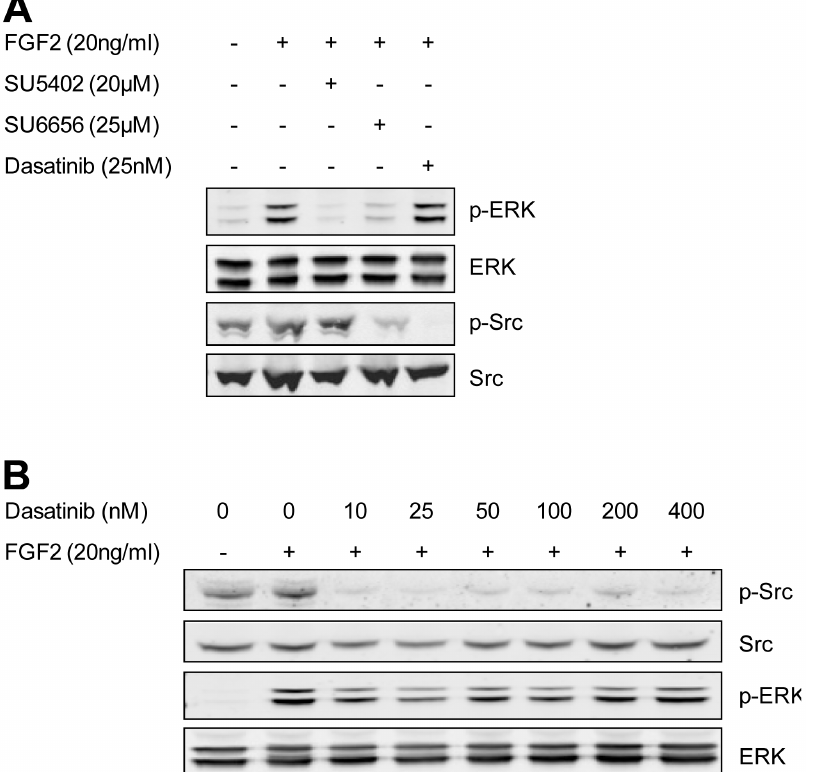
Figure 1. Chemical inhibition of Src kinase and FGFR kinase activity. A) HEK 293T cells were treated with SU5402, SU6656, or dasatinib 30 min prior to addition of FGF2 for 15 min. Cells were lysed and analysed by western blotting. B) HEK 293T cells were treated with increasing concentrations of dasatinib for 30 min prior to addition of FGF2 for 15 min. Cells were lysed and analysed by western blotting.